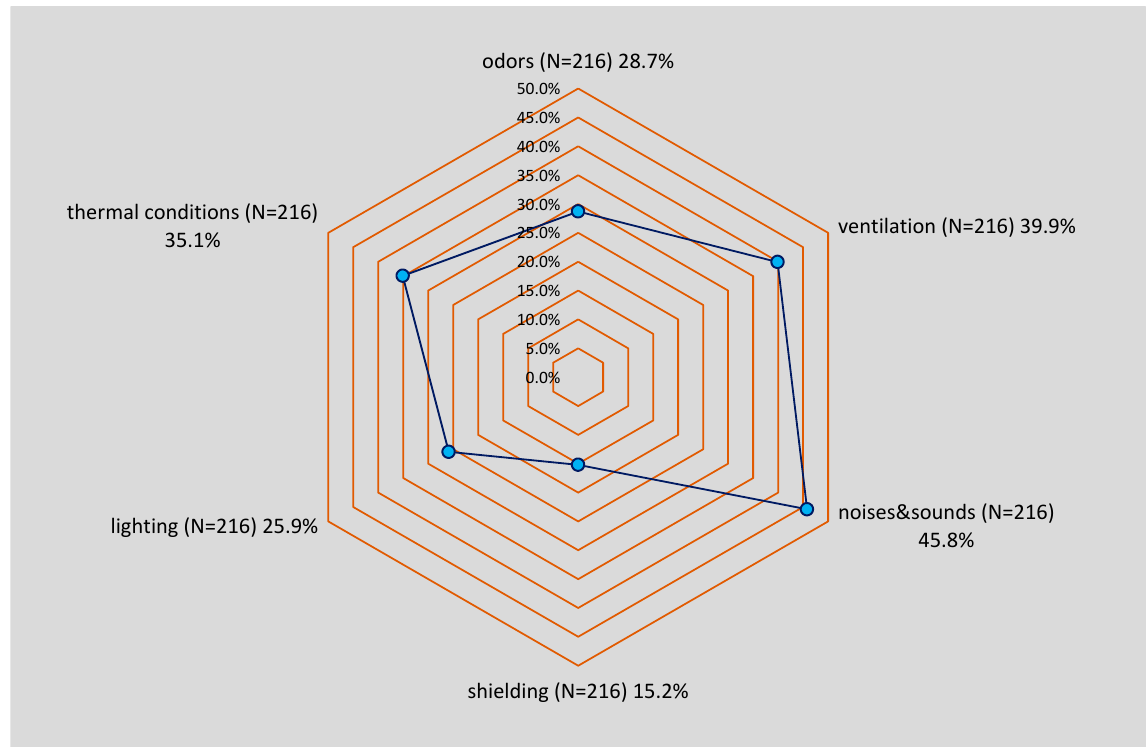
Figure 4. The proportion of respondents who thought that certain IEQ parameters affected their health negatively ( N = 216). Table 4. The minimum and maximum values of the measured IEQ